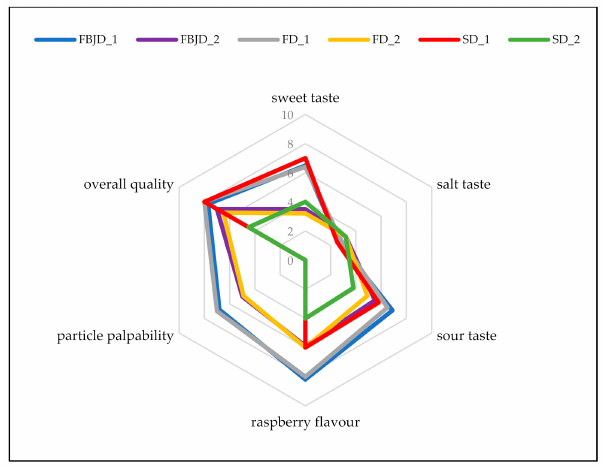
Figure 5. The sensory qualities of the designed recovery